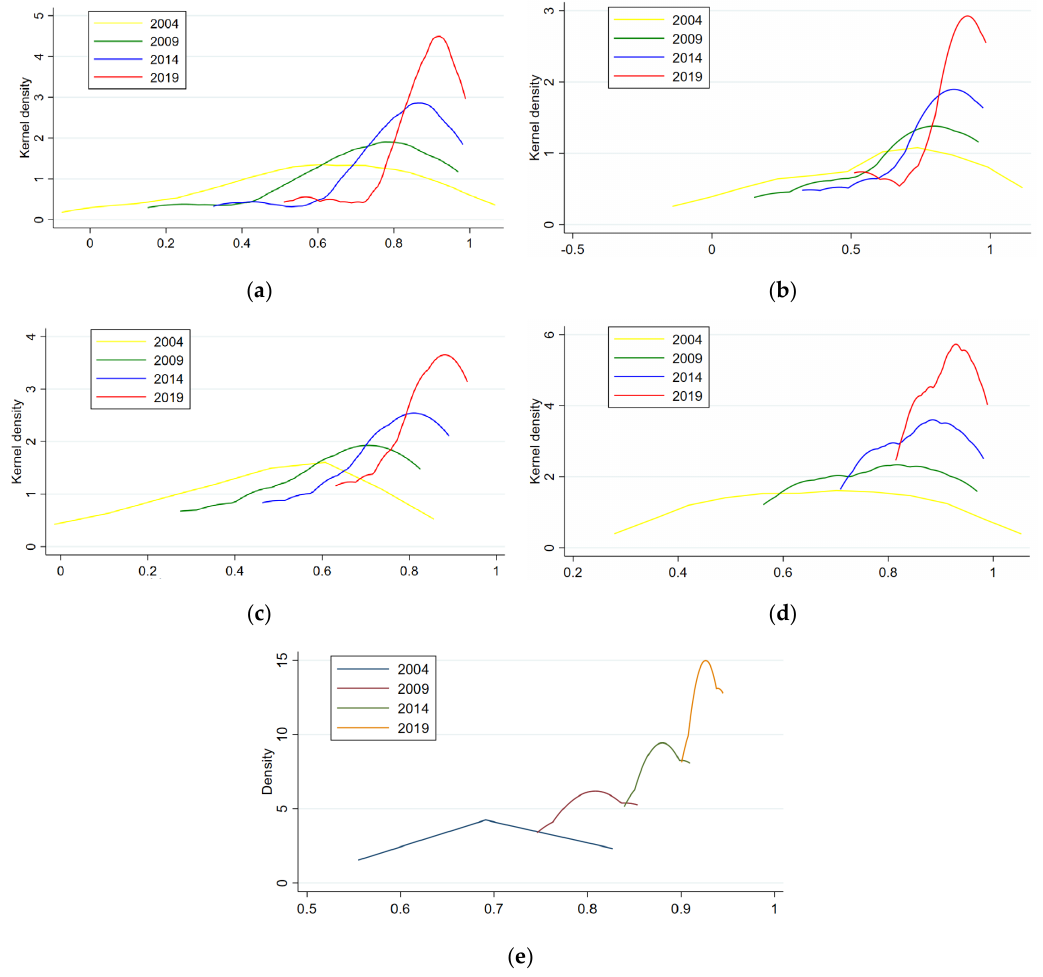
Figure 3. Estimation of kernel density of green grain production efficiency. ( a ) National kernel density estimates. ( b ) Eastern region kernel density estimates. ( c ) Central region kernel density estimates. ( d ) Western region kernel density estimates. ( e ) Northeastern region kernel density estimates.